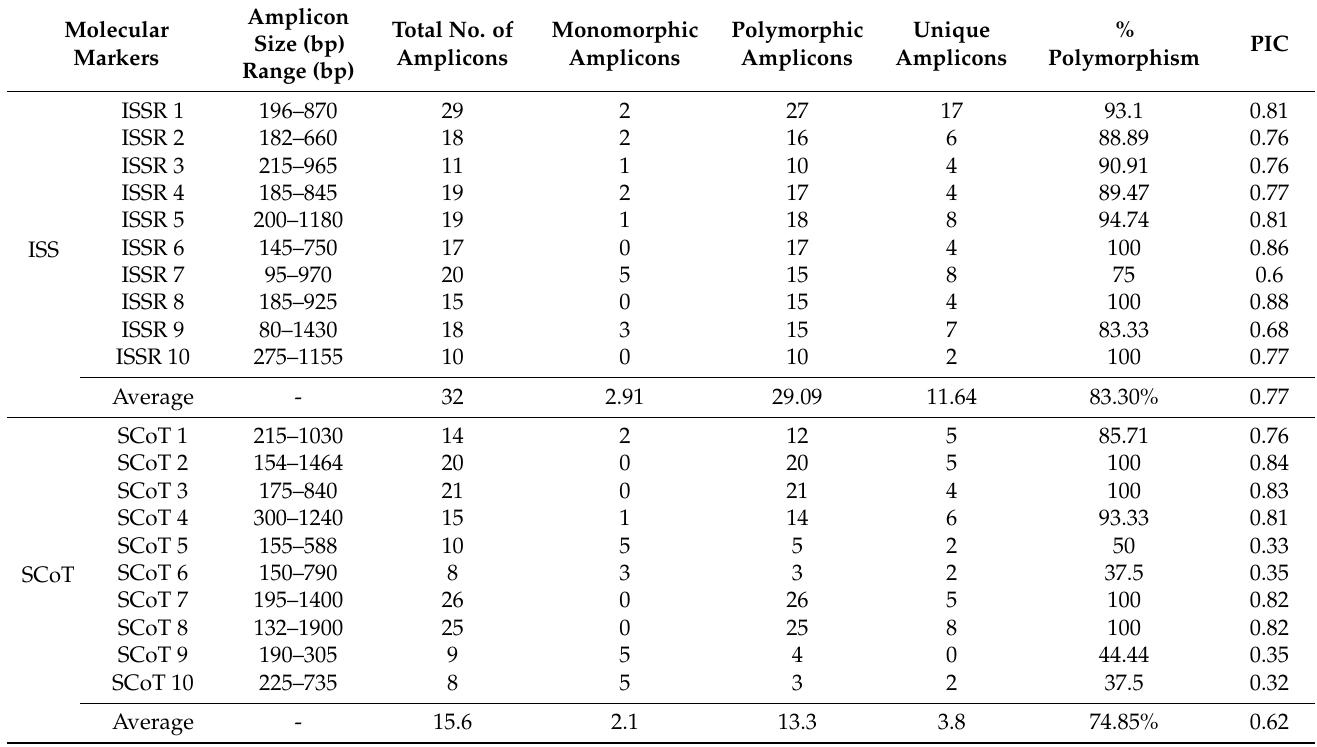
Table 2. Features of ISSR and SCoT molecular markers used to study the genetic diversity of quinoa